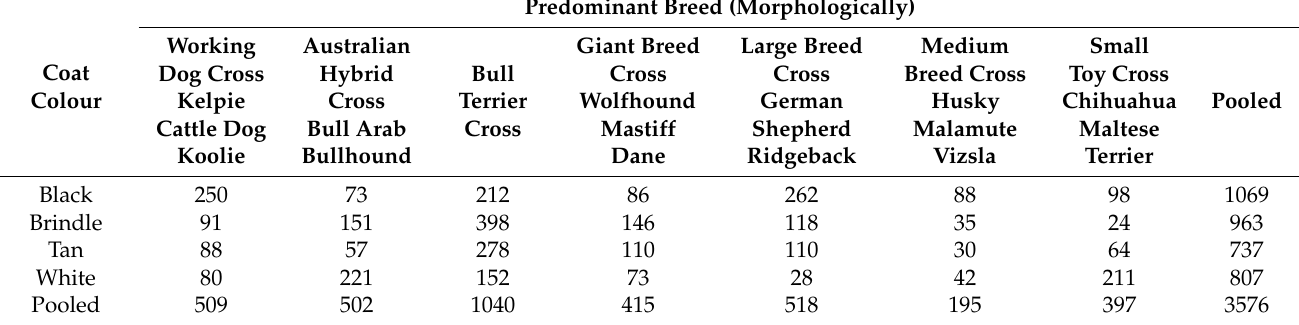
Table 5. Numbers of adoptions by dog coat colour and breed used to assess associations between these variables and time-to-readmission to RSPCA Queensland for dogs adopted from RSPCA Queensland in 2019 and